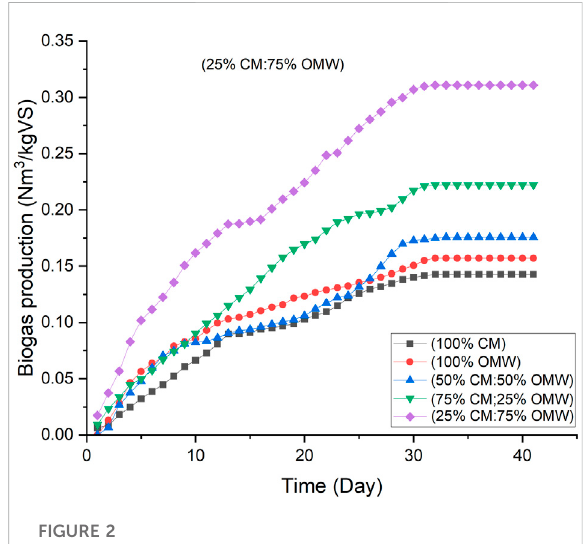
FIGURE 2 Cumulative biogas production of co-digestion of CM and OMW digestion in different